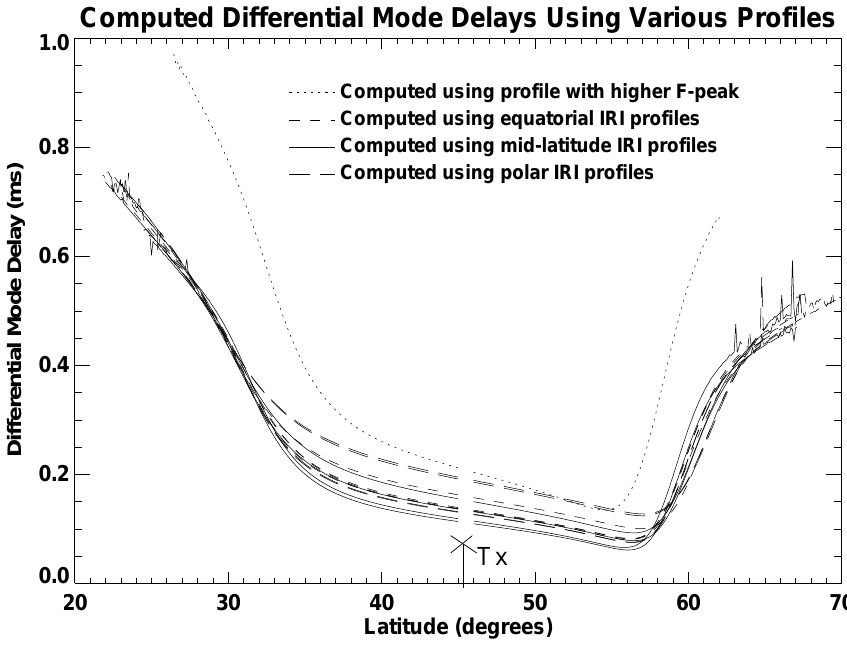
Fig. 8. The simulated differential mode delay at various satellite latitudes using each electron density profile listed in Table 1. Results show higher differential mode delay values for profiles with higher TEC above the transmitter. Away from the transmitter, profiles with the same fo F2 peak produce similar values, but the profile with a higher peak results in much higher differential mode delay values.